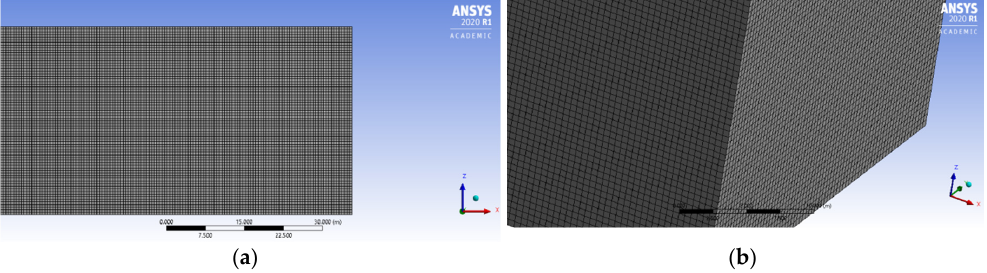
Figure 2. The computational domain meshed using equidistant structured mesh in both the Fluent and CFX simulations: ( a ) the full 3D computational domain and ( b ) a horizontal (x-y) plane with the computational, structured, hexahedral